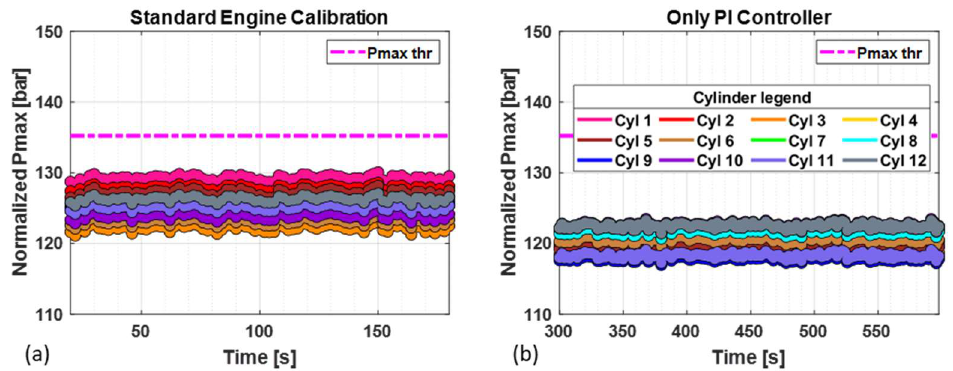
Figure 13. Comparison between the MFB50 optimum, threshold and actual values produced by all the 12 cylinders at 1800 rpm and 100% pedal: ( a ) when the ECU is using only the open loop control, ( b ) when the PI control of SOC and TOC are active.